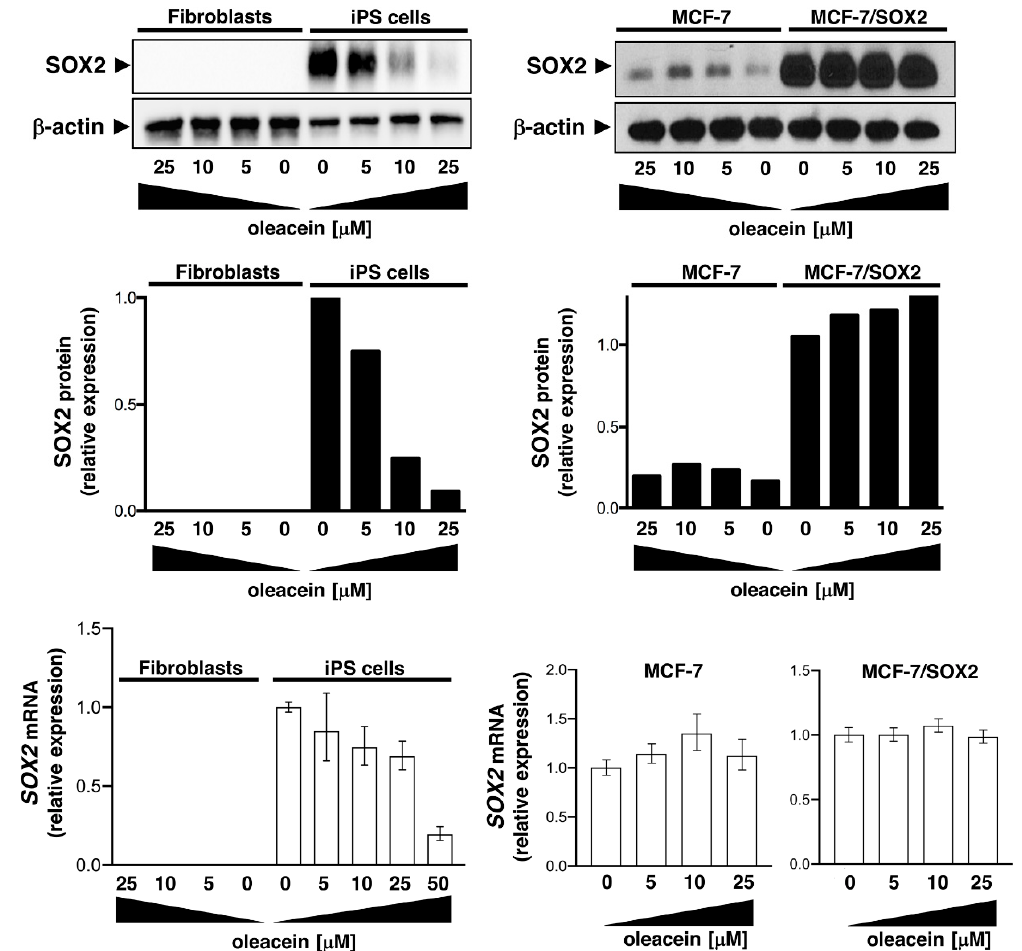
Figure 5. Oleacein suppresses stemness-related SOX2 protein expression. Western blotting analyses of SOX2 protein levels in human fibroblasts, induced pluripotent stem (iPS) cells, MCF-7, and MCF-7/SOX2 cells cultured in the absence or presence of graded concentrations of oleacein. β -actin expression was employed as an internal loading control. Images are representative of two independent experiments. Total RNA from human fibroblasts, iPS cells, MCF-7, and MCF-7/SOX2 cells cultured in the absence or presence of graded concentrations of oleacein was characterized in technical triplicates for the relative abundance of SOX2 using RT-PCR analysis. The transcript abundance was calculated using the delta Ct method and presented as fold-change v ersus basal expression in untreated cells. 4. Discussion In the present study, we used several approaches to identify the lysine-specific histone demethylase LSD1 as a novel target for oleacein, a characteristic bioactive biophenol-secoiridoid in EVOO. First, we provide computational evidence supporting a catalytic/enzymatic inhibitory mechanism of action likely involving highly potent and direct targeting of the FAD cofactor cavity of LSD1 at physiological concentrations of oleacein. Because the interaction of LSD1 with RCOR1/CoREST allows the formation of an H3-tail binding-site recognizing a 20-amino-acid portion of the histone H3 N-terminal region [49,50], we cannot exclude the possibility that higher concentrations of oleacein might additionally target LSD1 via a scaffolding/structural mechanism involving disruption of the chromatin-binding activity of the LSD1/RCOR1/CoREST complex. Upon